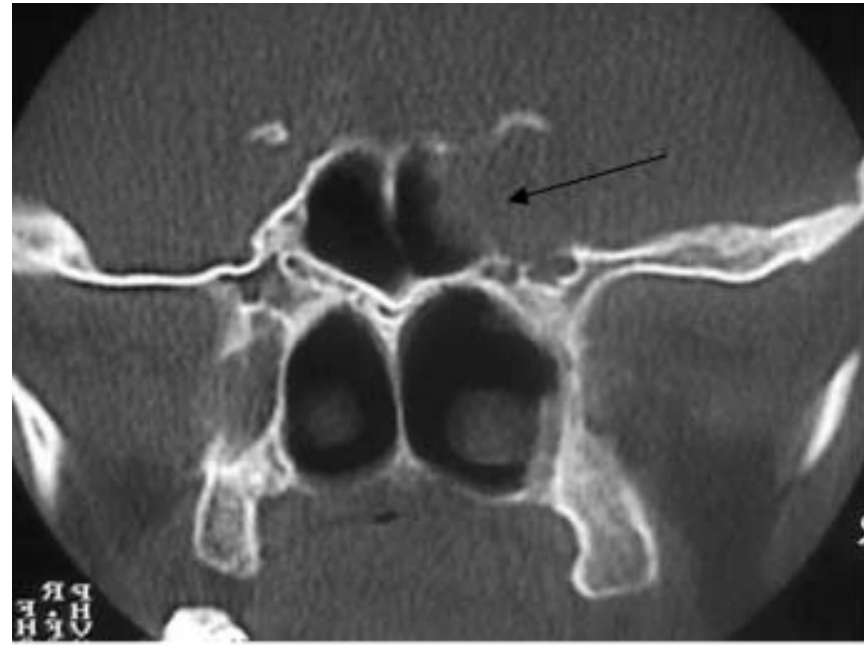
Suprasellar arachnoid cyst (black arrow) destructing the sphenoid